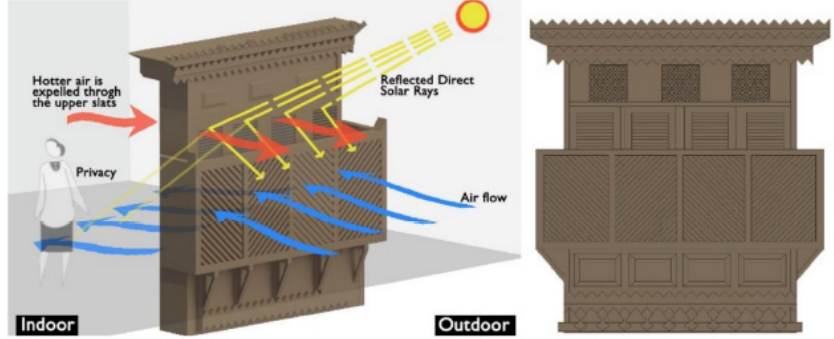
Figure 1. Example of mashrabiya demonstrating its principal functions [173].